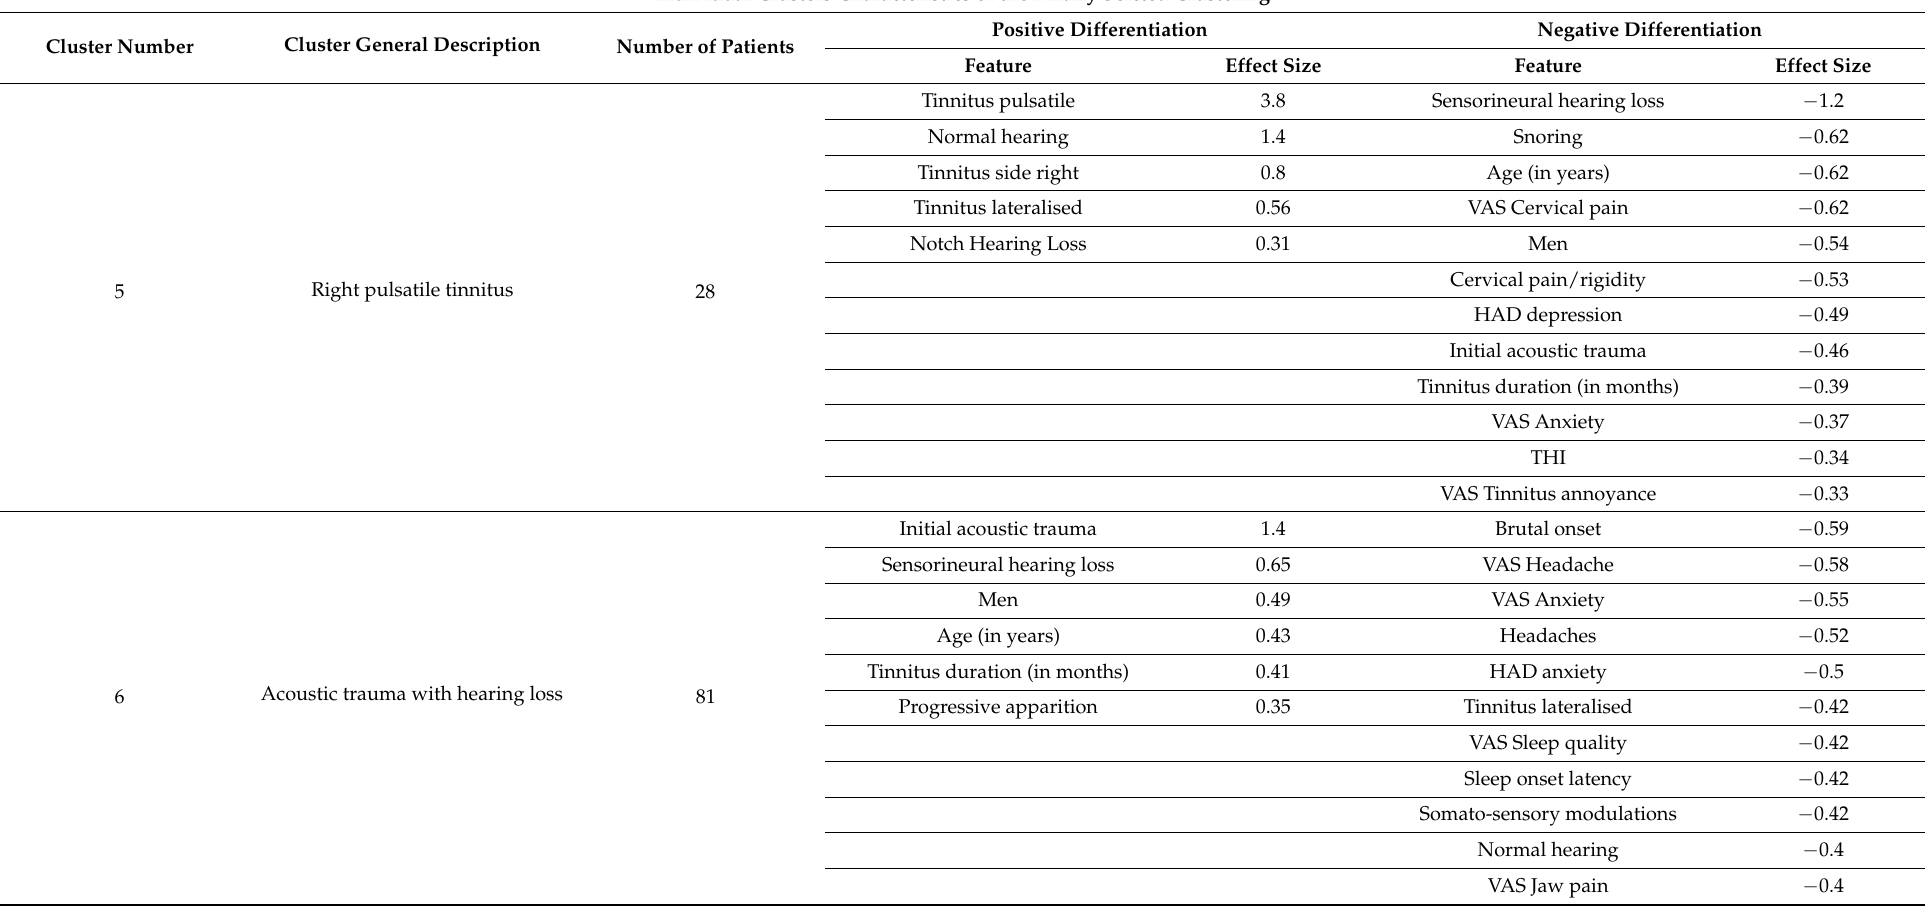
Individual Clusters Characteristics of the Finally Selcted